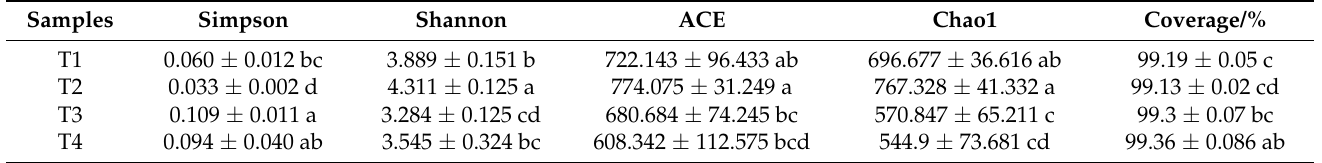
Table 2. Bacterial richness and diversity in composting